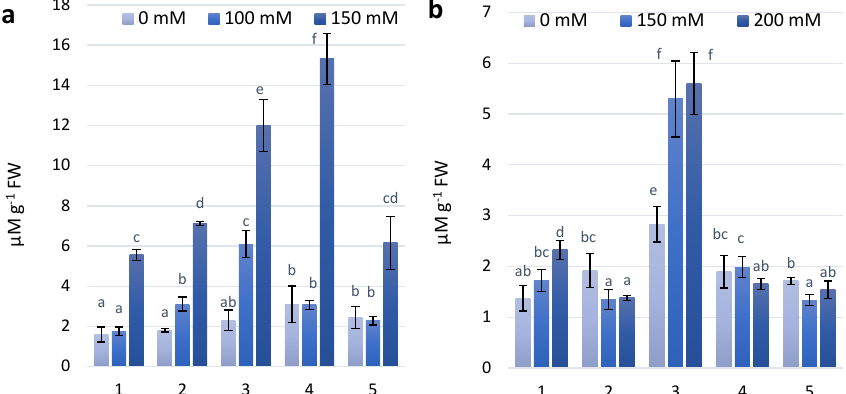
Figure 4. Proline content in wheat leaves under effect of different NaCl concentrations ( a )—first stage of treatment; ( b )—second stage of treatment. Wheat genotypes: 1—Citrus yellow, 2—KM 53-14 Blue, 3—KM 178-14 purple, 4—Skorpion Blue aleurone, 5—PS Karkulka purple. The columns represent the mean values ± S.E. for six replicates. Statistically significant differences among treatments at each time are indicated by different small letters (Duncan test, p < 0.05).